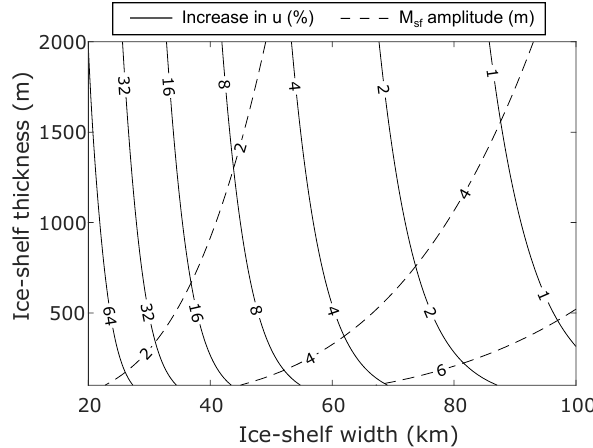
Figure 2. Contour plot of ice shelf speed-up due to tides, as a per- cent of the baseline speed, predicted by the analytical solution in Eq. (18). Speed-up is predicted along the ice shelf medial line us- ing parameter values given in Table 1. Also shown are contours of the amplitude of the M sf signal in ice shelf displacements (dashed